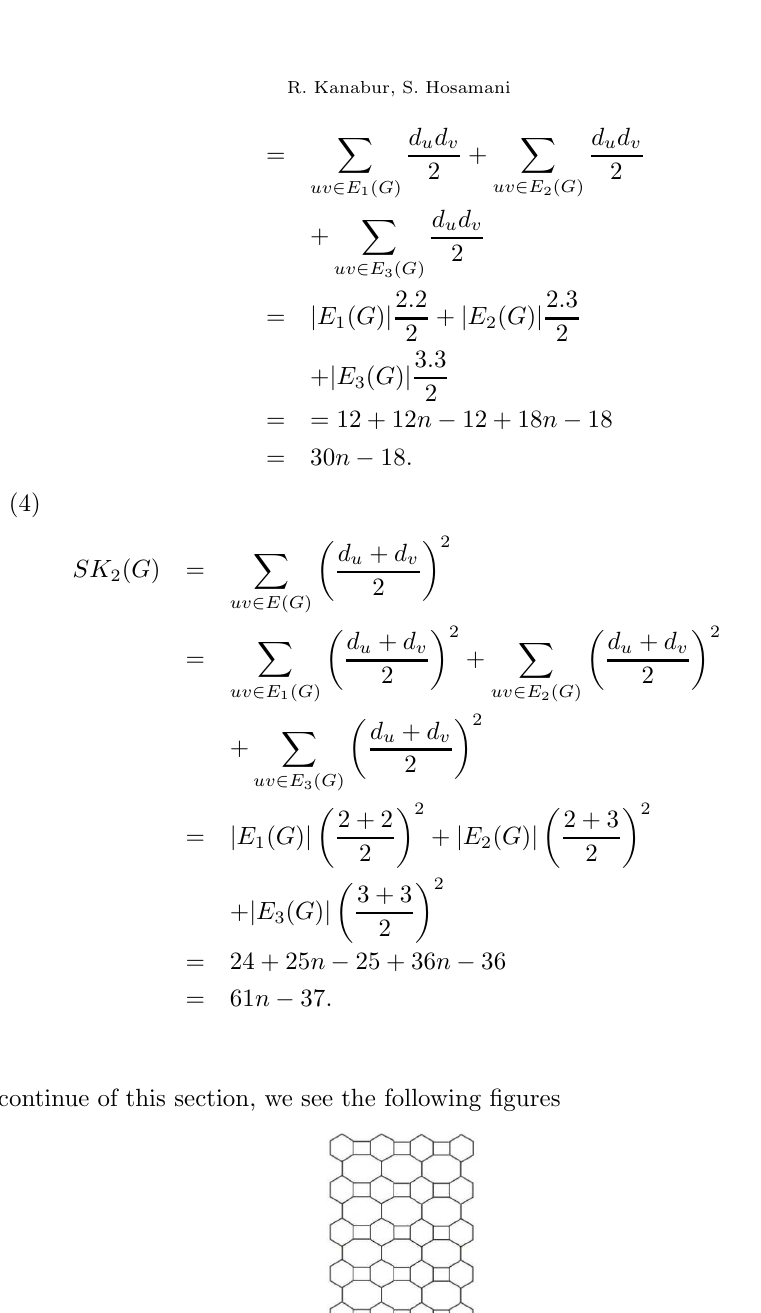
Figure 2. The 2-D graph lattice of C 4 C 6 C 8 [4 , 5]